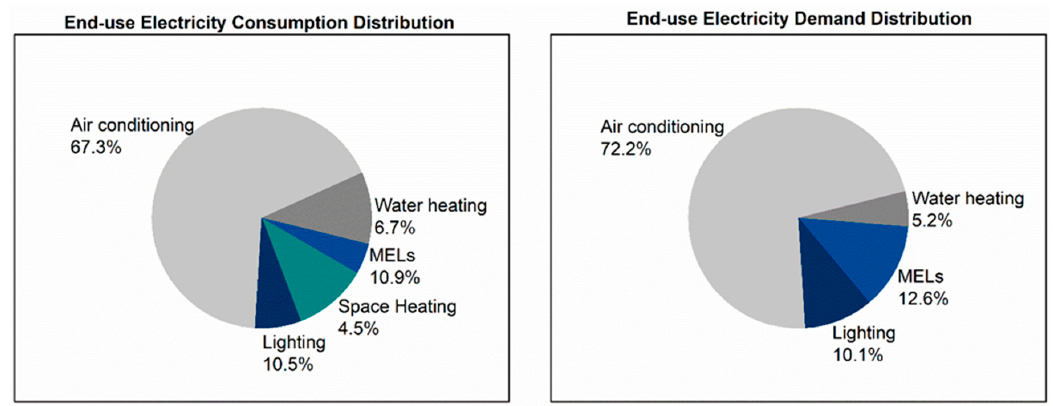
Figure 9. Distribution of on-site residential energy use and demand in Kuwait.